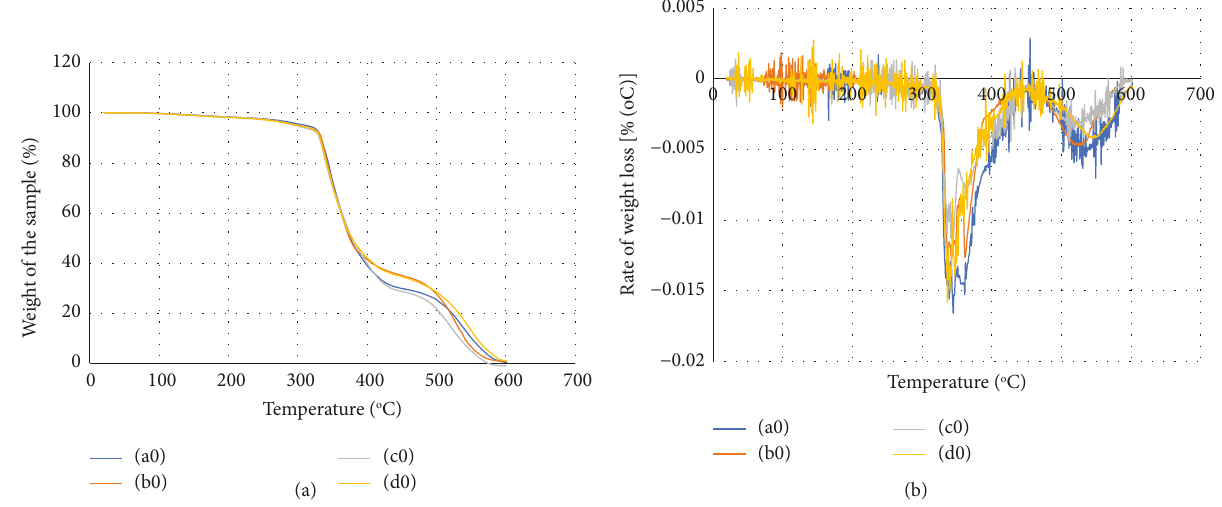
Figure 10: (a) TG and (b) DTG curves of BC fabricated under various sonicating temperatures: 70 ° C (a0), 65 ° C (b0), 60 ° C (c0), and 55 ° C (d0).